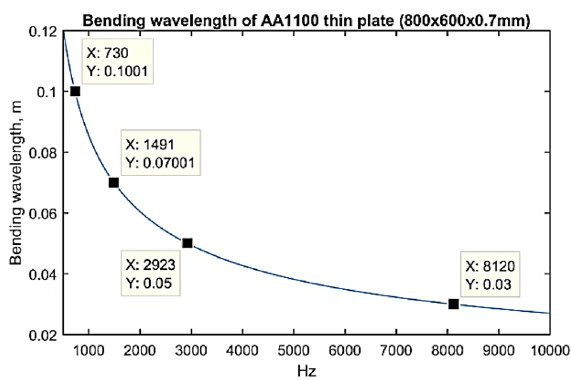
Figure 6. The estimation of effective line moment mobility, Y linear scale).